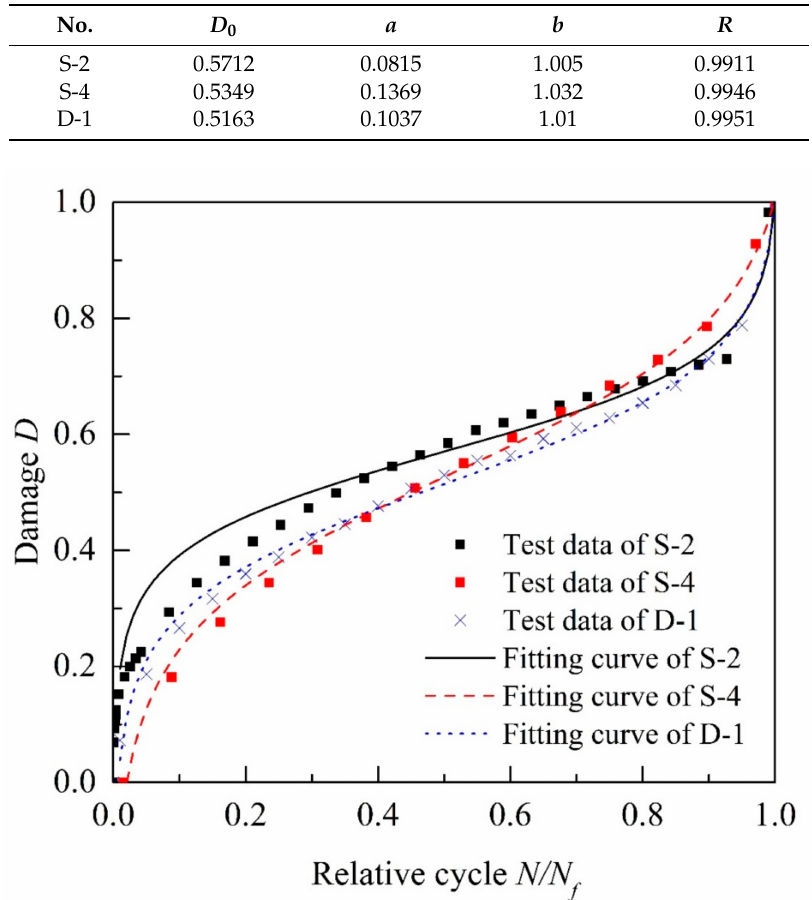
Figure 10. Fitting result of the inverted